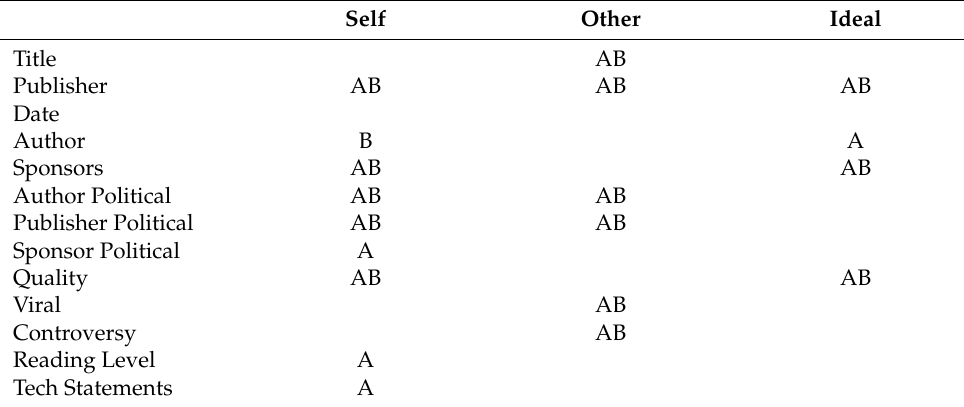
Table 3. Metrics with over 50% indicating a lot or a great deal by school. ‘A’ indicates University A and ‘B’ indicates University